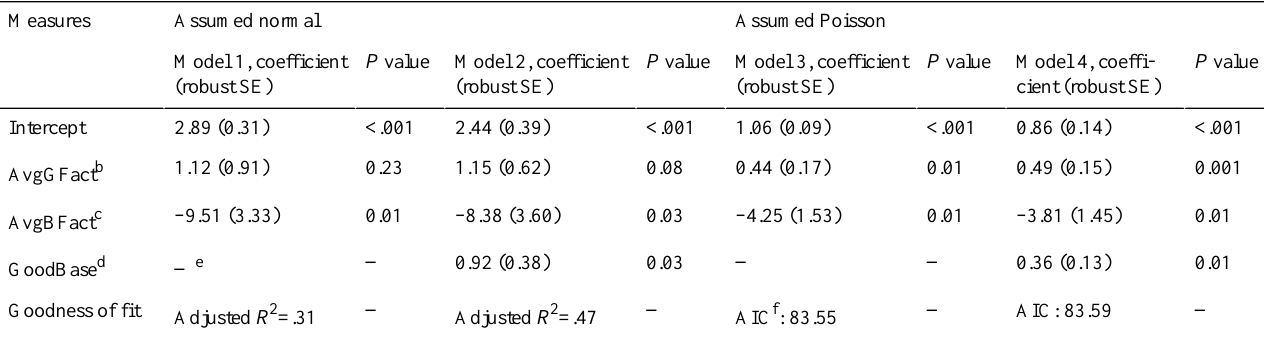
Table 8. Regression results for GoodChoice a